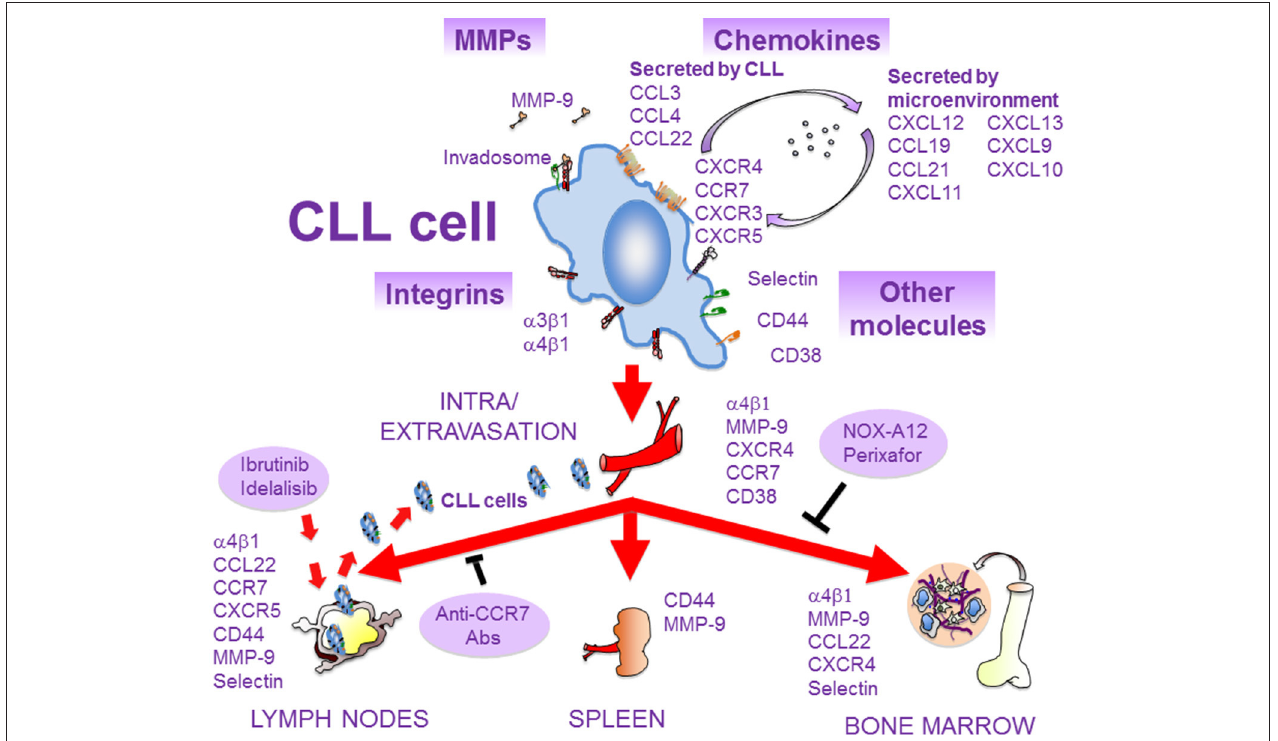
FIGURE 2 | Molecules involved in the migration of CLL cells . As CLL progresses, malignant cells extravasate and infiltrate the BM and secondary lymphoid organs. This process is mediated by several molecules, expressed and/or secreted by CLL cells or by the microenvironment of lymphoid tissues. Some of these molecules interact physically and/or functionally and may constitute the CLL cell invadosome. The α 4 β 1 integrin is critical for CLL cell homing to BM and LNs, and blocking BCR signaling with ibrutinib or idelalisib inhibits α 4 β 1 function and results in lymphocytosis. The chemokine receptors CCR7 and CXCR4 are crucial for CLL cell traffic to LNs and BM, respectively. These receptors can be blocked by specific antibodies or inhibitors (NOX-A12, perixafor). MMP-9, CD44, and CD38 are also important for CLL cell migration and localization in lymphoid niches. Adhesive interactions with stromal cells in these niches, mediated by some of the depicted molecules, favor survival and chemoresistance of CLL cells and contribute to disease